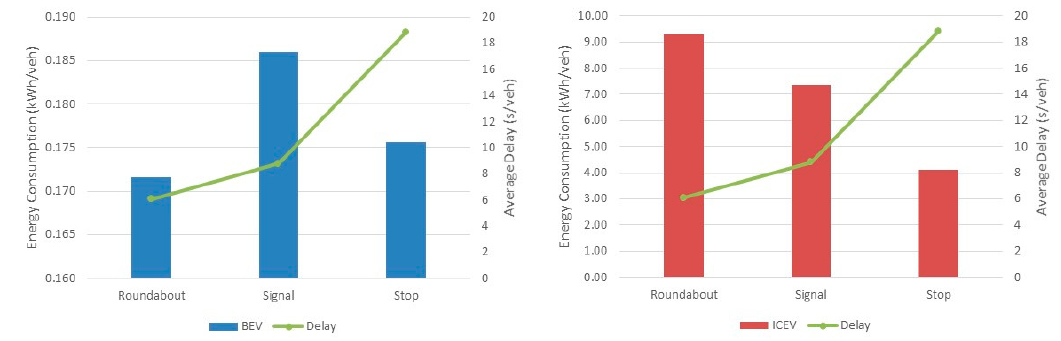
Figure 2. Comparison of battery electric vehicle (BEV) and internal combustion engine vehicle (ICEV) energy/fuel consumption for different intersection control strategies (approach speed = 88 km/h).